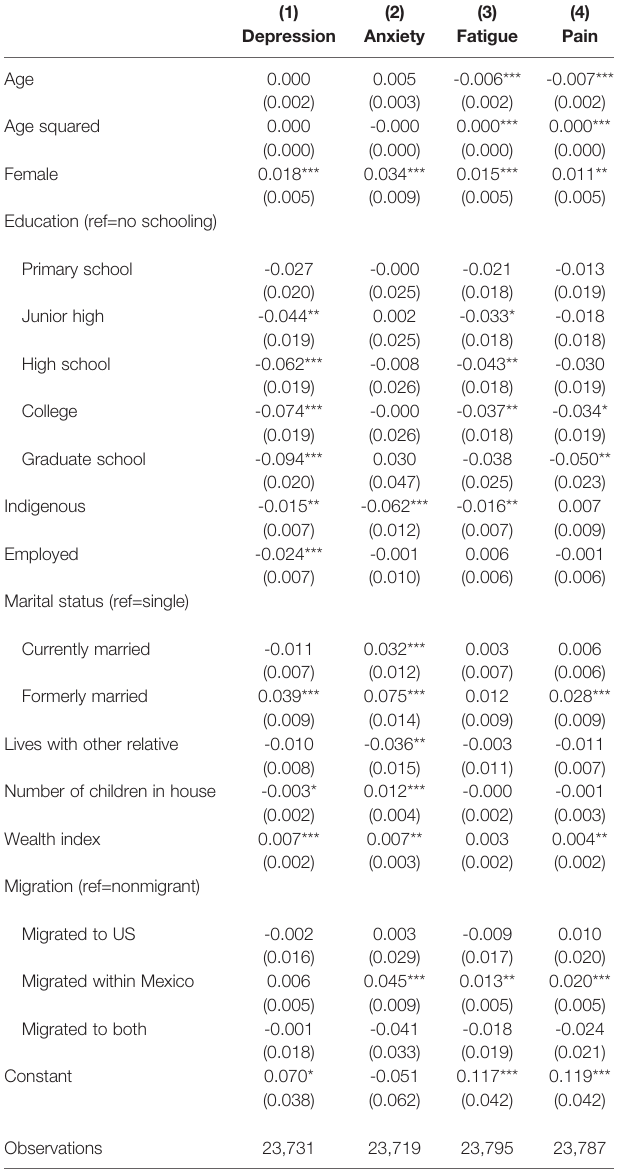
TABLE 2 | OLS models predicting self-reported depression, anxiety, fatigue, and